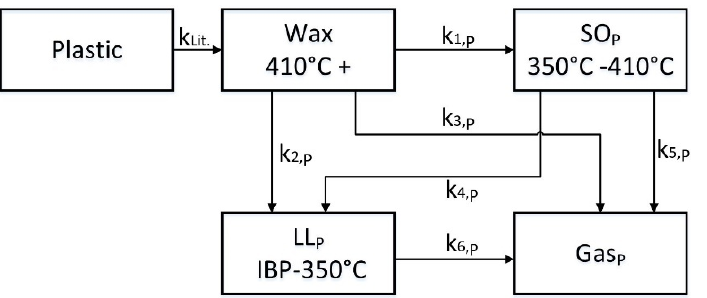
Figure 3. 5-lump model for the plastic pyrolysis with six monomolecular, irreversible, first order reactions and one starting reaction of the plastic degradation.